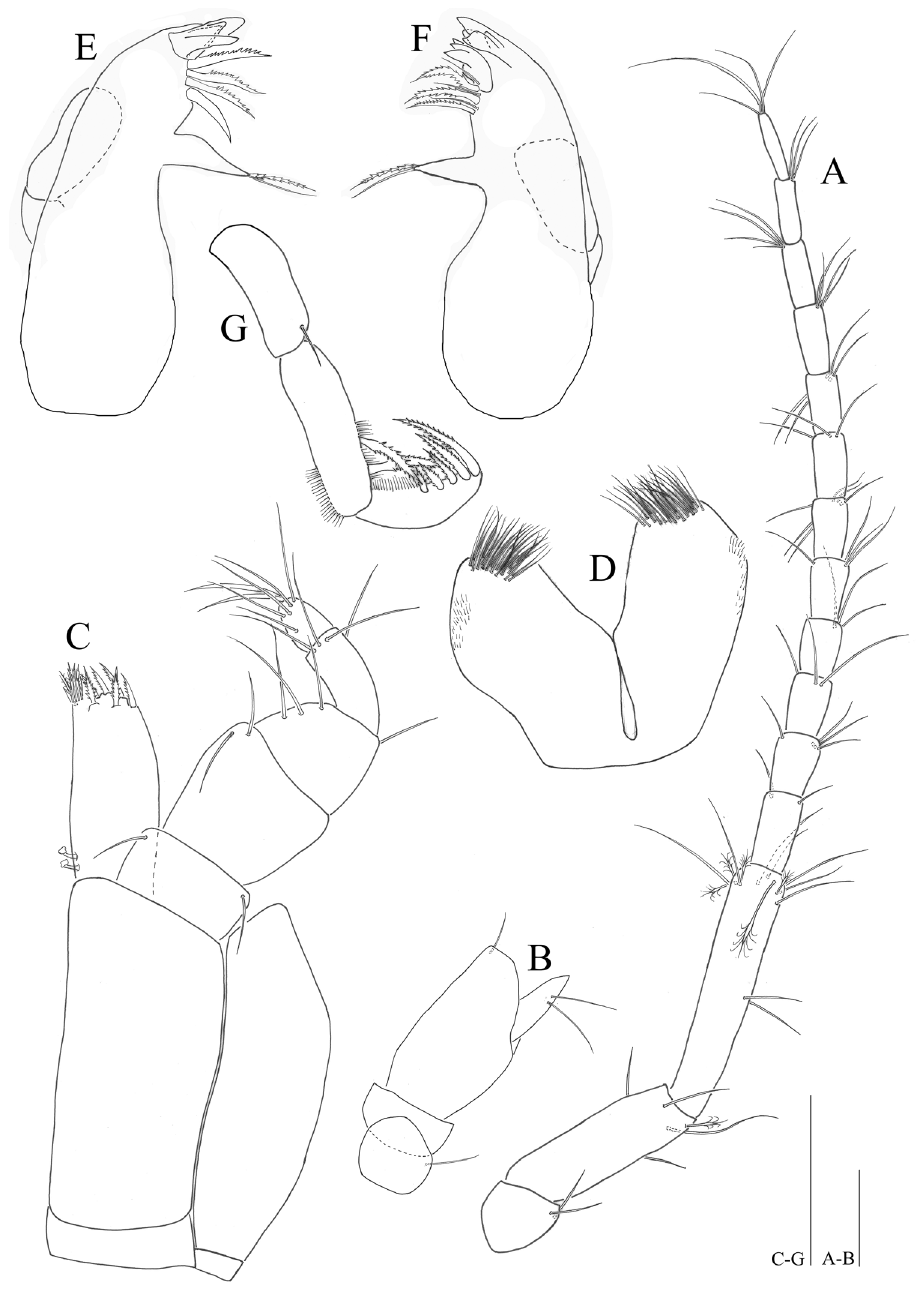
Figure 3. Microcharon tanakai sp. n., holotype, female. A antennal articles 4-6 with flagellum, dorsal B antennal articles 1-3, dorsal C maxilliped dorsal D paragnaths dorsal E left mandible, dorsal F right mandible, dorsal G mandibular palp, ventral. A–B scale bars 100µm, C–G scale bars 50